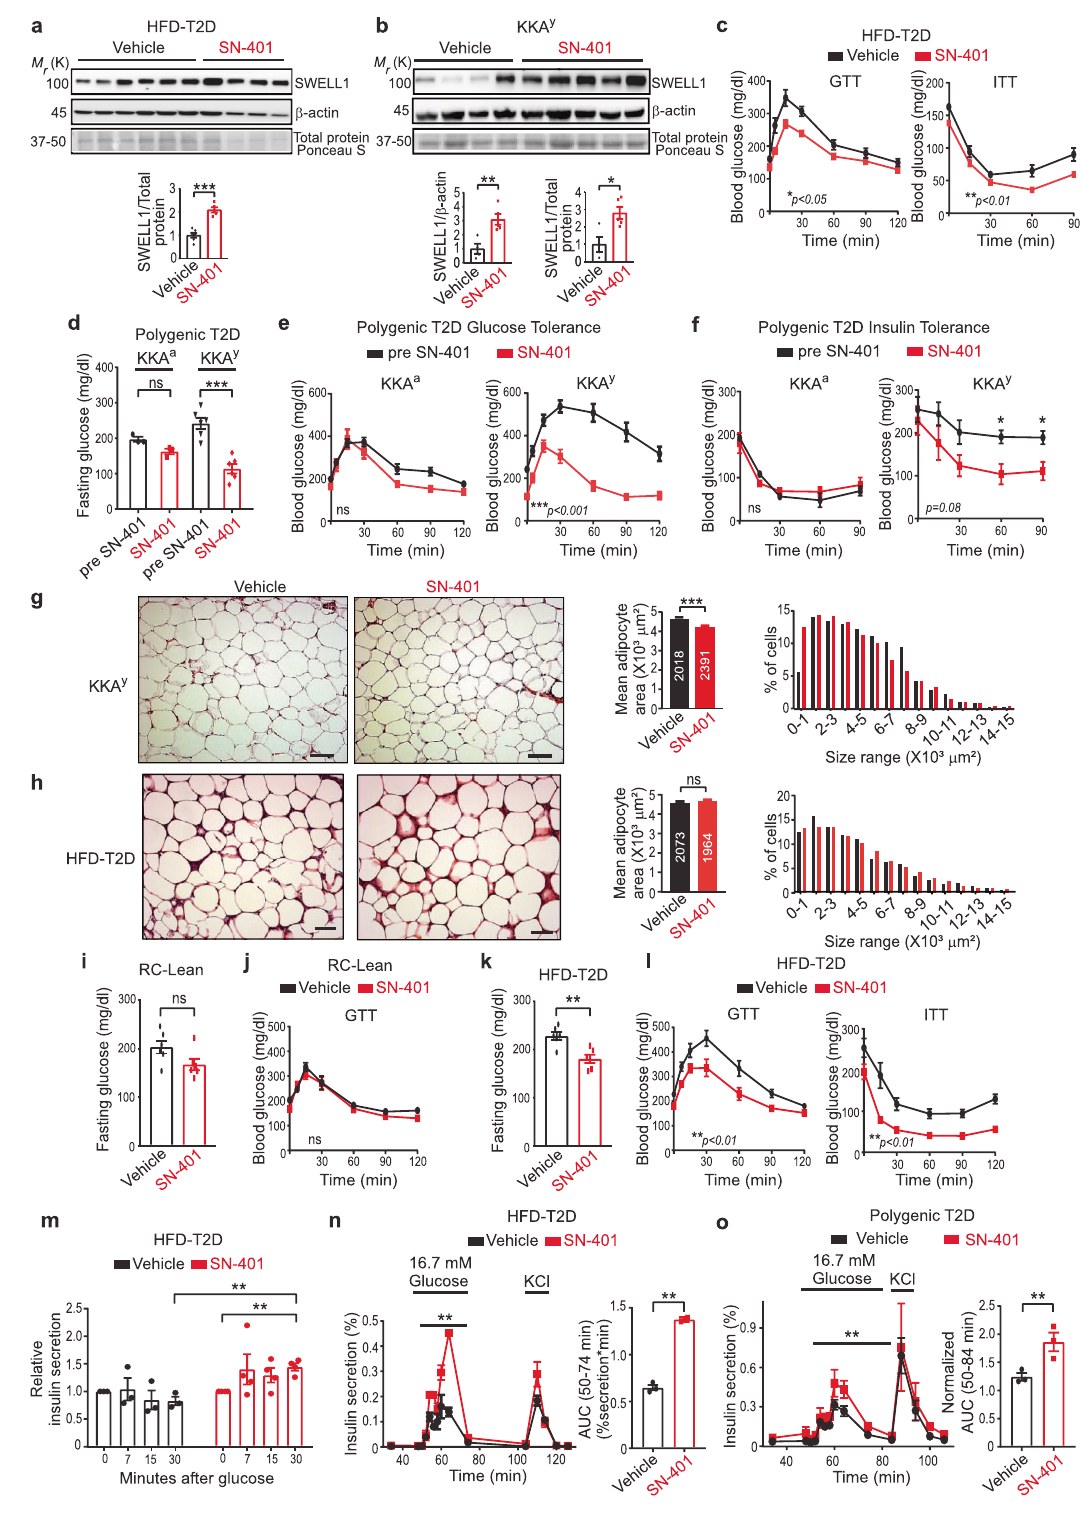
metabolism via effects in the liver, pancreatic β -cells, and adipocytes 48 . FGF21 is an endocrine hormone that is expressed in the liver, pancreas, and adipose tissue, but under physiological conditions is largely a liver-derived hepatokine 49 , and is a potent regulator of glucose and lipid metabolism 50 . Curiously, we found that serum adiponectin was unchanged in SN-401 treated KKA y mice as compared to vehicle (Fig. 4j), while serum FGF21 was